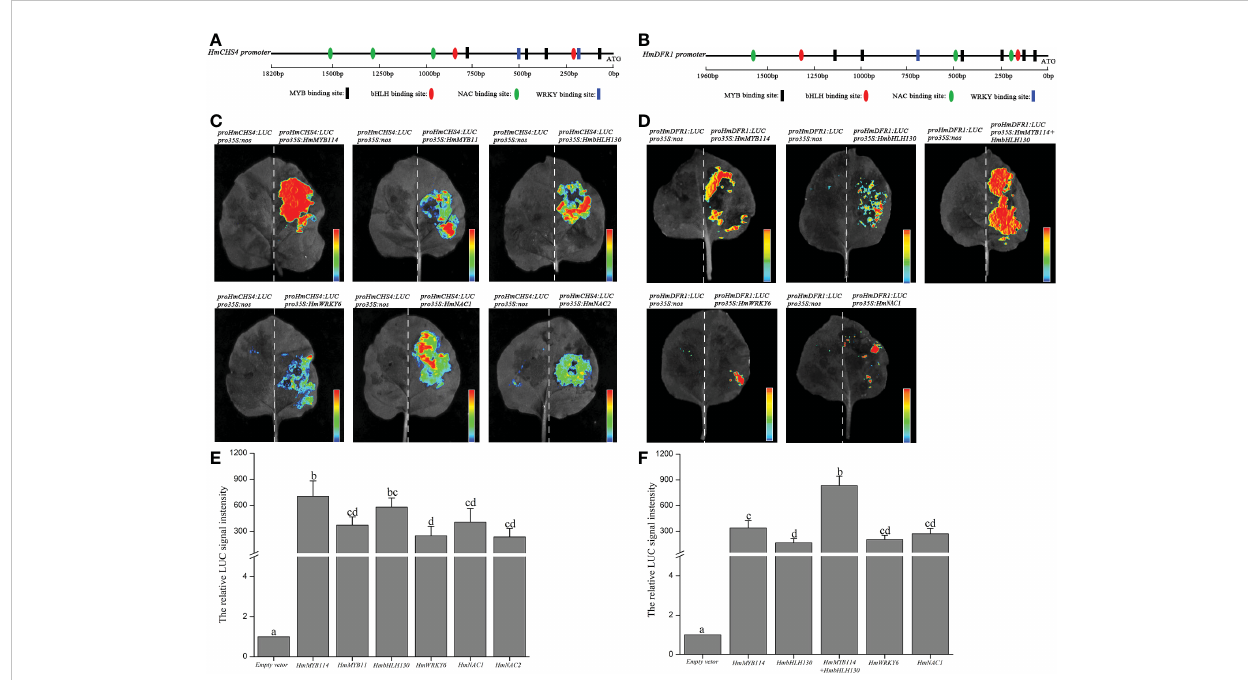
FIGURE 6 Transactivation assays of HmCHS4 and HmDFR1 promoters by HmMYB114, HmMYB11, HmbHLH130, HmWRKY6, HmNAC1, and HmNAC2 transcription factors. (A, B) Schematic overview of HmCHS4 and HmDFR1 promoters. (C, D) Imaging of luciferase enzyme activity of HmCHS4 and HmDFR1 promoters. Luciferase activity was detected in the tobacco leaves. The 35S-nos construct is used as a negative control. (E, F) The relative luciferase signal intensity of HmCHS4 and HmDFR1 promoters were measured in the effector and reporter vector. Values are the means ± standard deviation (SD). Data is the mean of three biological replicates. Different lowercase letters indicated signi fi cant differences at 0.05